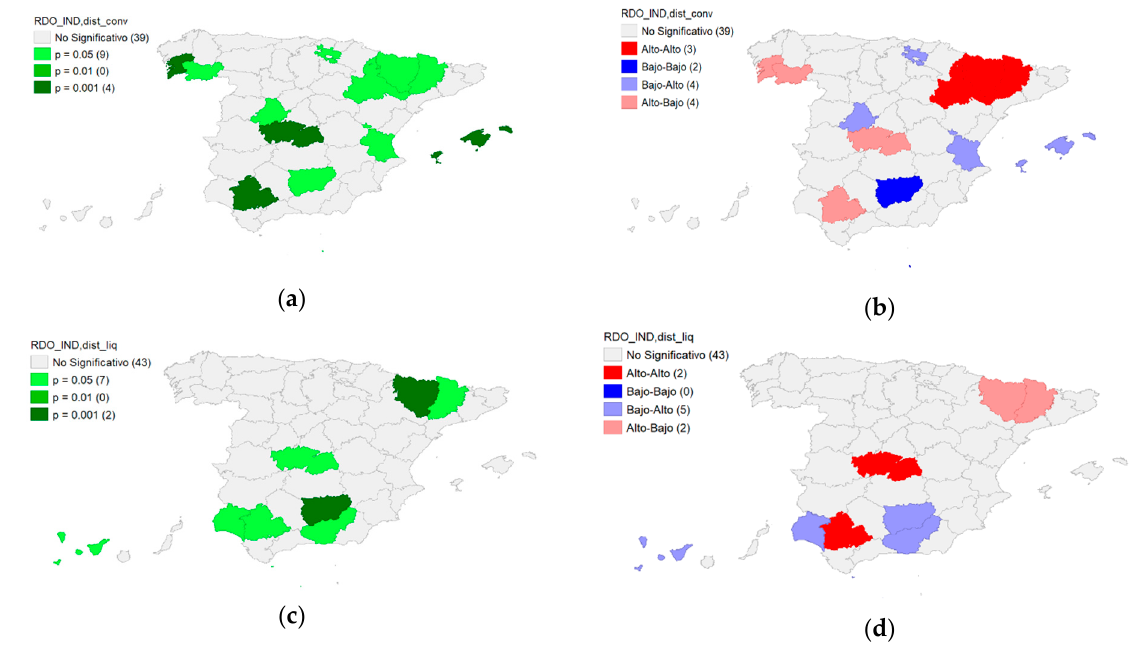
Figure 10. Maps of significance and clusters with Iag success for manufacturing firms ( a , b ) and maps of significance and clusters with Iag liquidation for manufacturing firms ( c , d ).